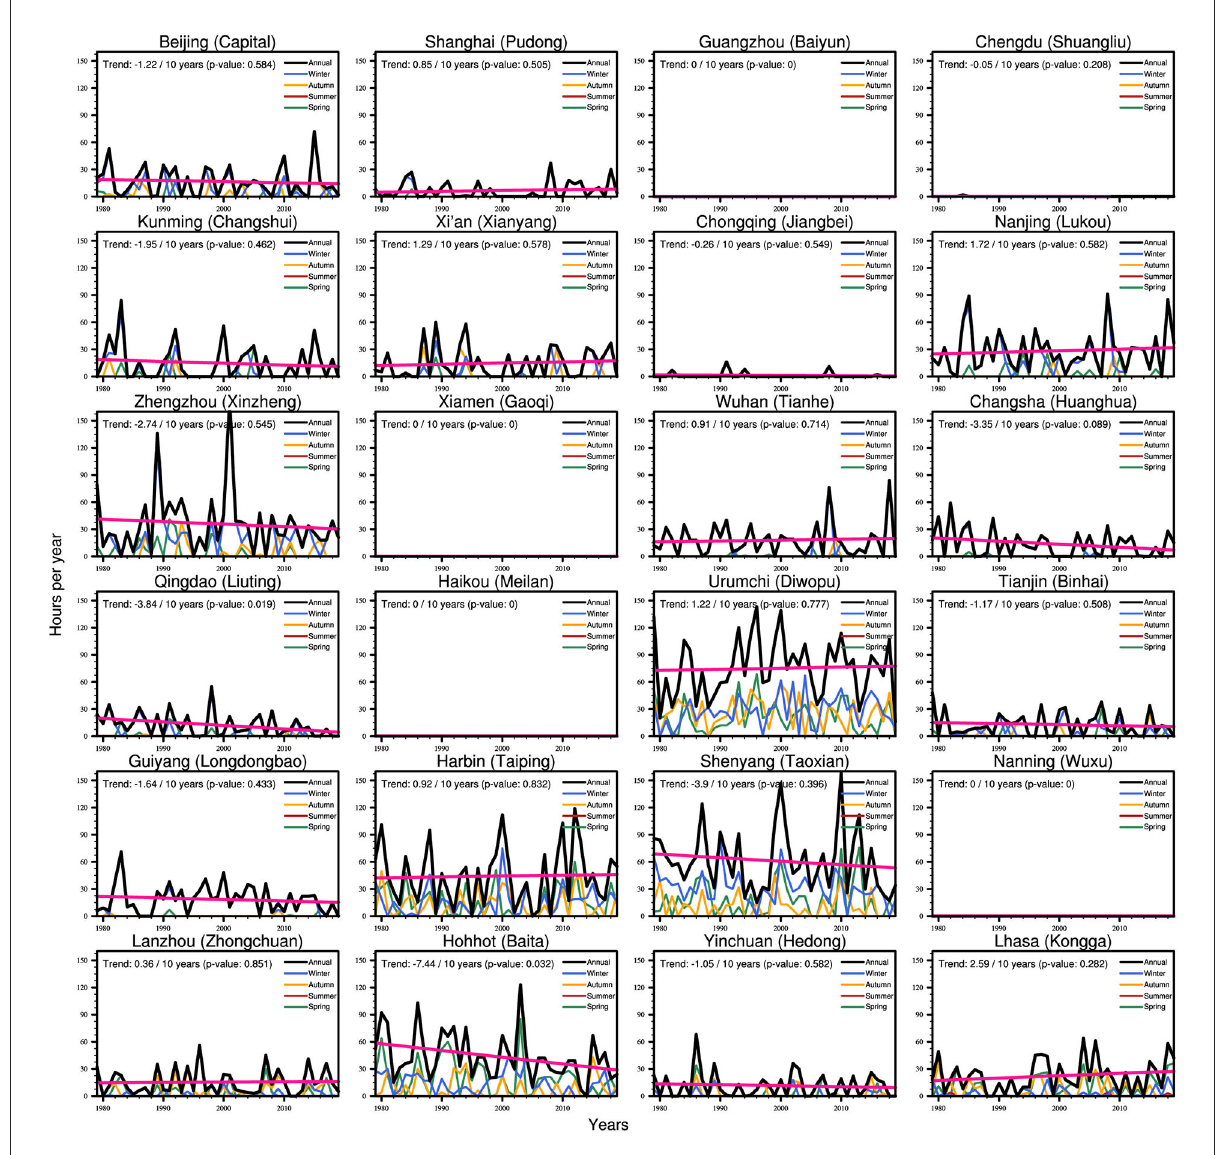
FIGURE12 Same as Figure 9, but for SNOW from the ERA5-land reanalysis.